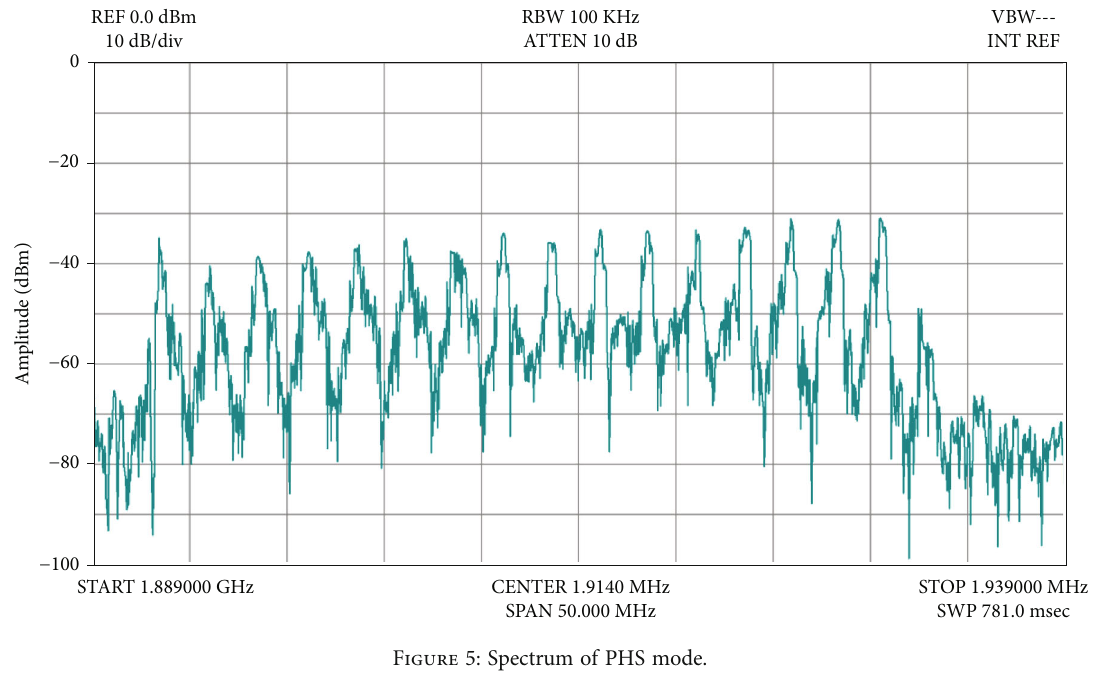
Figure 5: Spectrum of PHS